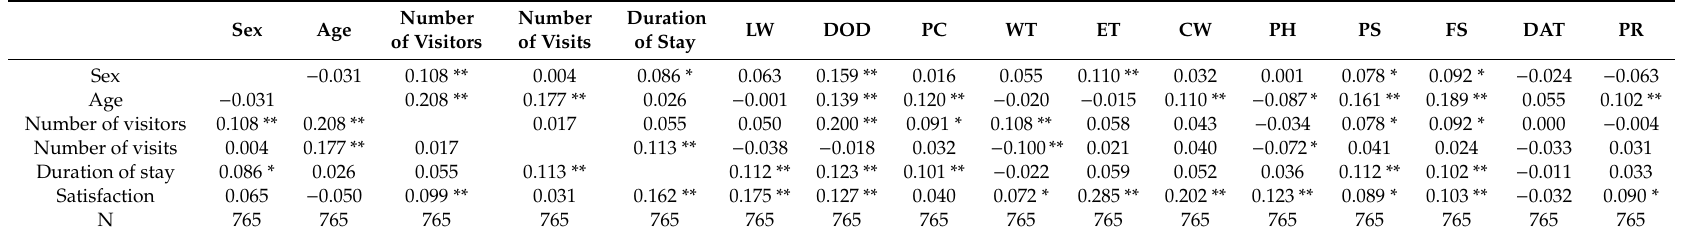
Table 4. Correlation analysis between di ff erent visitor attributes and trail selection preference